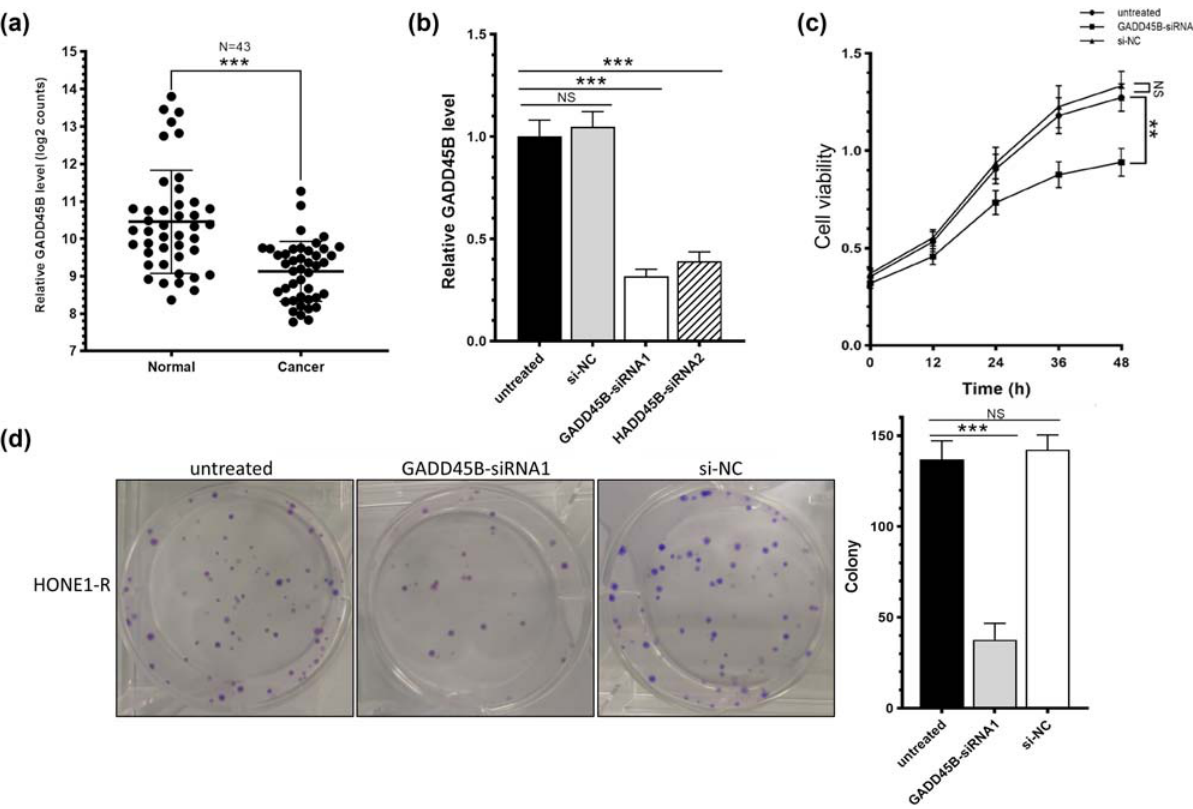
Figure 5: GADD45B e ff ectively improved the activity and proliferation of HONE1 - R cells under radiation: ( a ) TCGA database analysis of GADD45B in squamous cell carcinoma of head and neck; ( b ) e ff ectiveness and transfection e ffi ciency analysis; ( c ) cell viability of HONE1 - R cell line treated by 6 Gy; and ( d ) cell proliferation of HONE1 - R cell line treated by 6 Gy.